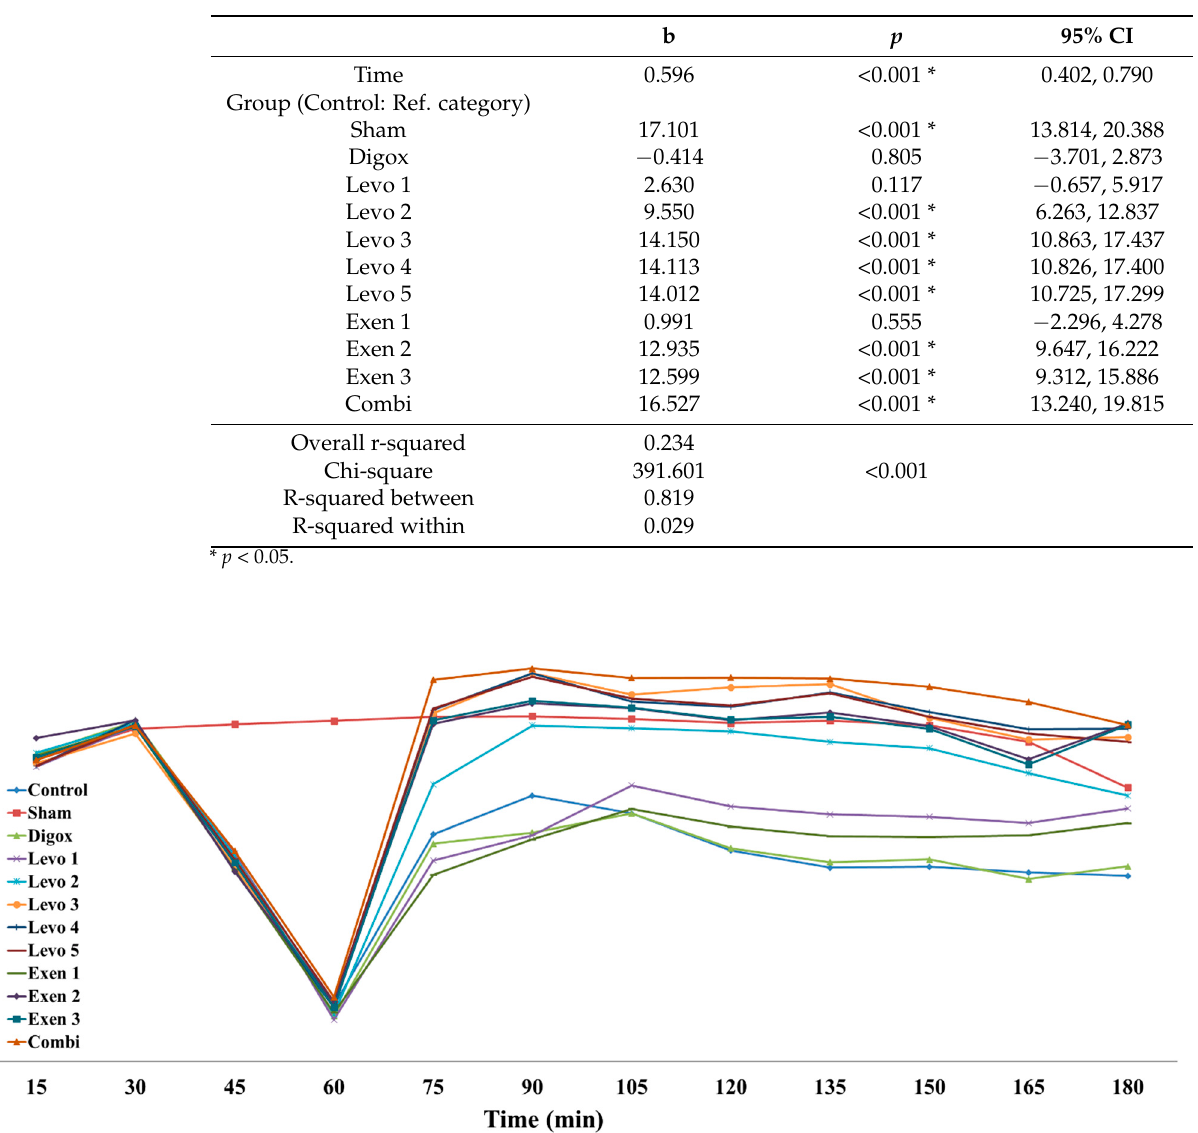
Table 1. Longitudinal analysis for LVSP for all groups.